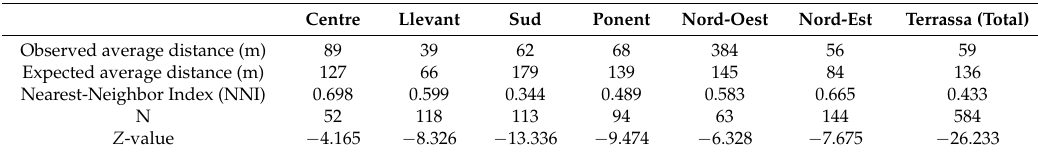
Table 2. Nearest-Neighbor Index (NNI) for neighborhoods in Terrassa. Centre Llevant Sud Ponent Nord-Oest Nord-Est Terrassa (Total)